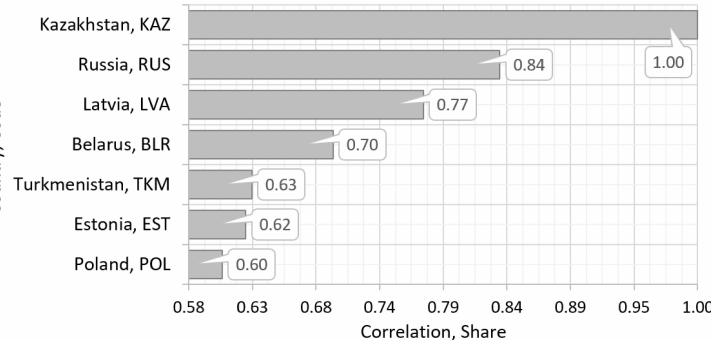
Figure 2. Distribution of countries by correlation coefficients. Note: developed by the authors.